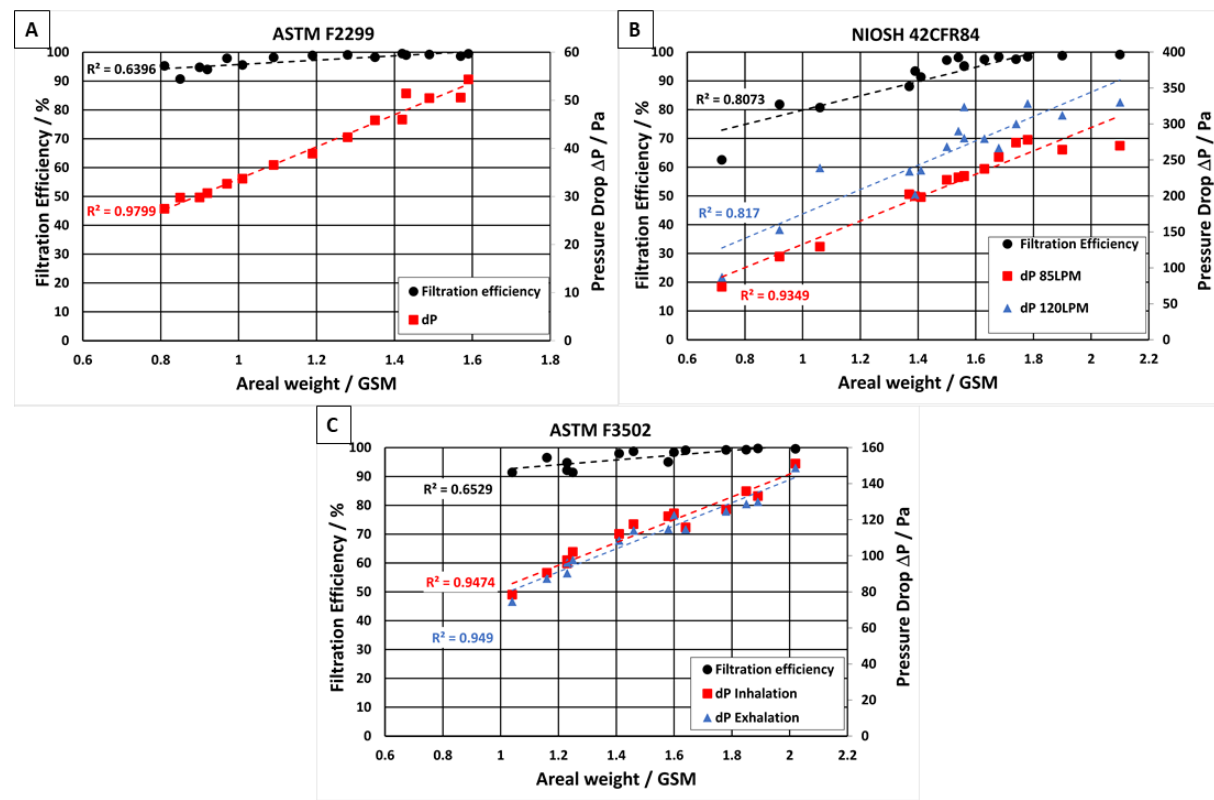
Figure 5. Filtration efficiency and pressure drop vs. NF areal weight (in gsm) when tested in accordance with different international standards: ( A ) ASTM F2299, ( B ) NIOSH 42CFR84, and ( C ) ASTM F3502.